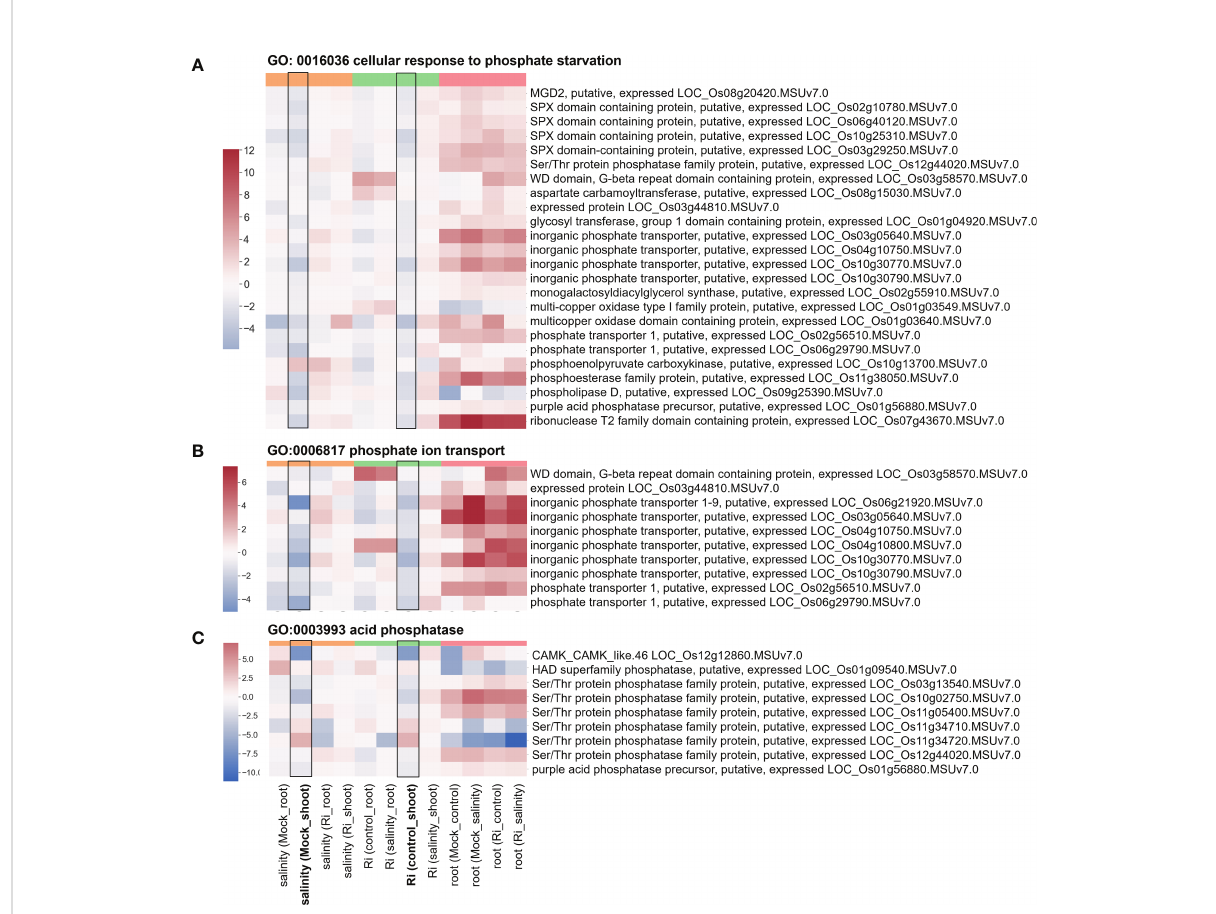
FIGURE 7 Heatmap showing the fold change of DEGs belonging to Pi homeostasis-related GO terms (A) Expression pro fi le of DEGs from region 7 with the GO term “ GO: 0016036 cellular response to phosphate starvation ” . (B) Expression pro fi le of DEGs from region 7 with the GO term “ GO:0006817 phosphate ion transport ” . (C) Expression pro fi le of DEGs from region 7 with the GO term “ GO:0003993 acid phosphatase ” . The log2(fold change) values of DEGs from the selected GO terms were visualized with a heatmap. The color bar on top of the heatmap indicates the DE comparison groups: orange – salinity effect; green – AM symbiosis; pink – tissue difference. On the x-axis, each column represents a pairwise comparison to show the effect causing the DE, and inside the parentheses are the